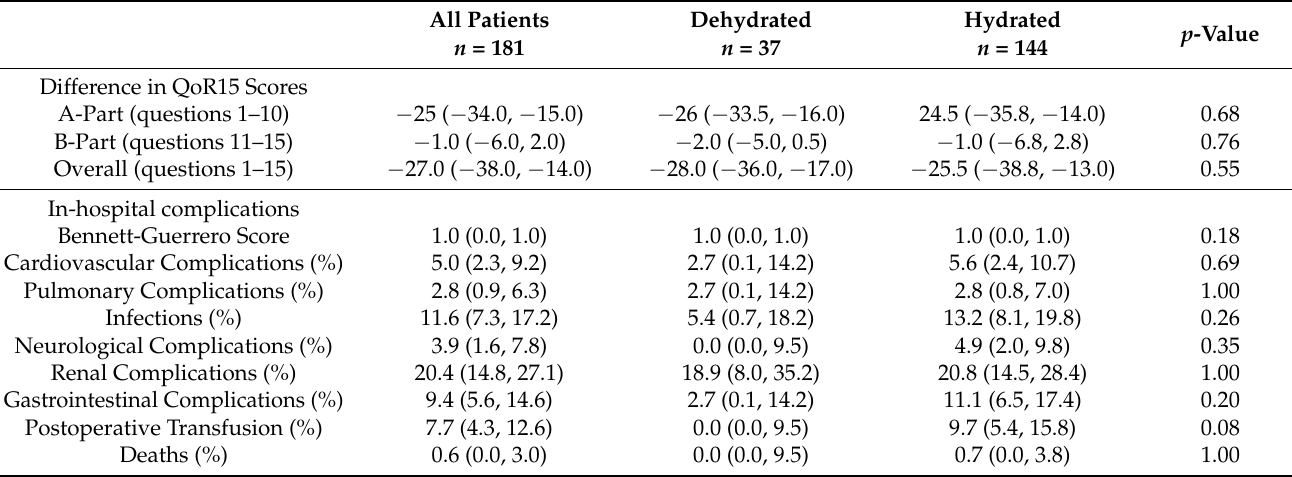
Table 3. Non-longitudinal secondary outcomes: Dehydration according to the fluid retention index (FRI) ≥ 4. Data are pre- sented median (25th–75th percentiles) for numeric outcomes and percentages (95% CI) for categorical/dichotomous outcomes.